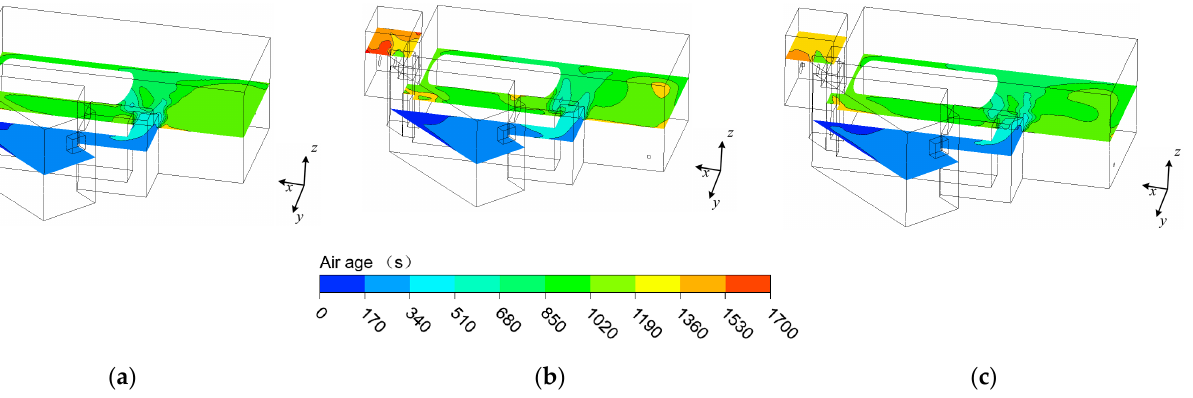
10 of 17 Figure 6. Velocity contour of layout scheme 12 (The scattering room z = 1.6 m and the sample room z = 2.4 m). The indoor air age distribution of three layout schemes (the scattering room z = 1.6 m and the sample room z = 2.4 m) are shown in Figure 7 where it can be seen that the most miniature air age is at the inlet and labyrinth channel, and the largest is in the sample